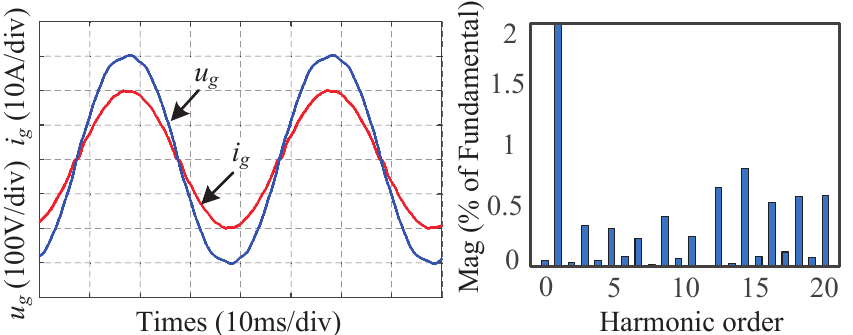
Figure 16. Output waveforms of the PIMR-RC system and spectrum analysis of the output current when f g = 49.6